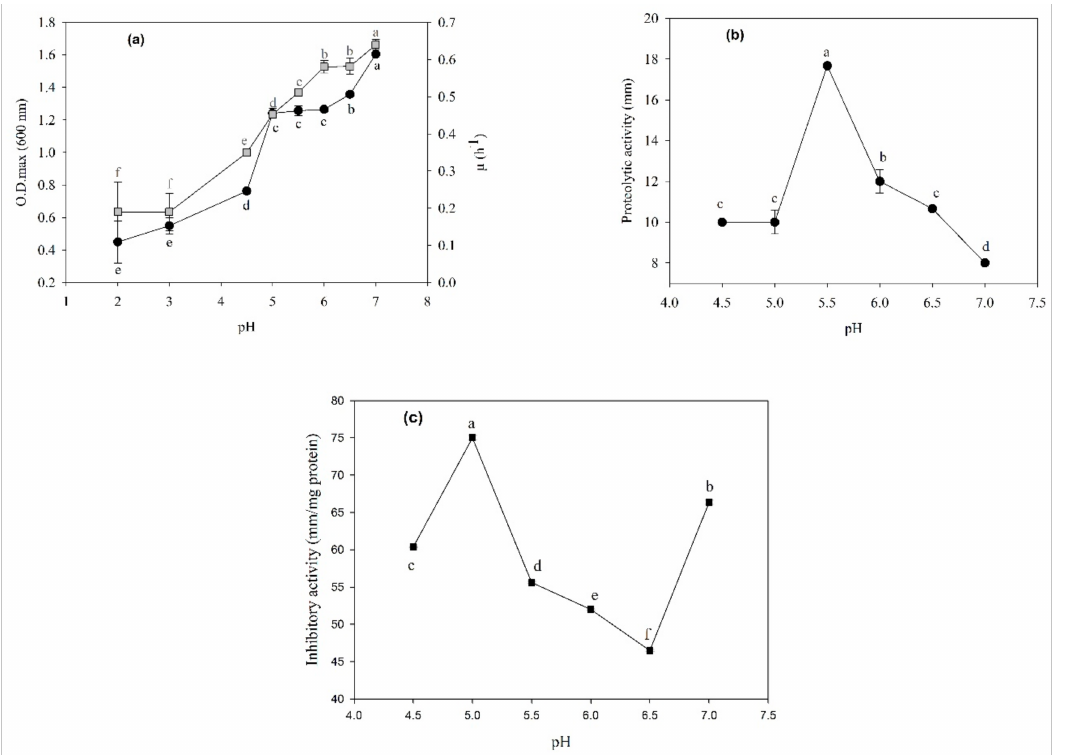
Figure 1. ( a ) Influence of pH (pH 2 and 3 for 9 h; pH 4.5–7 for 24 h) on the growth of P . pentosaceus 1101: O.D.max ( • ), µ ( (cid:4) ). ( b ) Proteolytic activity curve. ( c ) Inhibitory activity with Listeria innocua . The